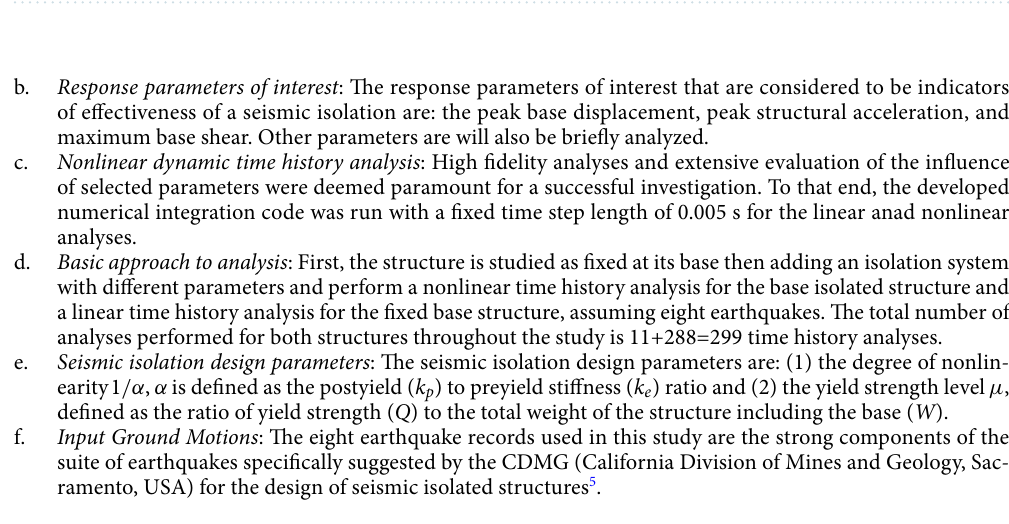
Table 1. Strong component of CDMG suite of